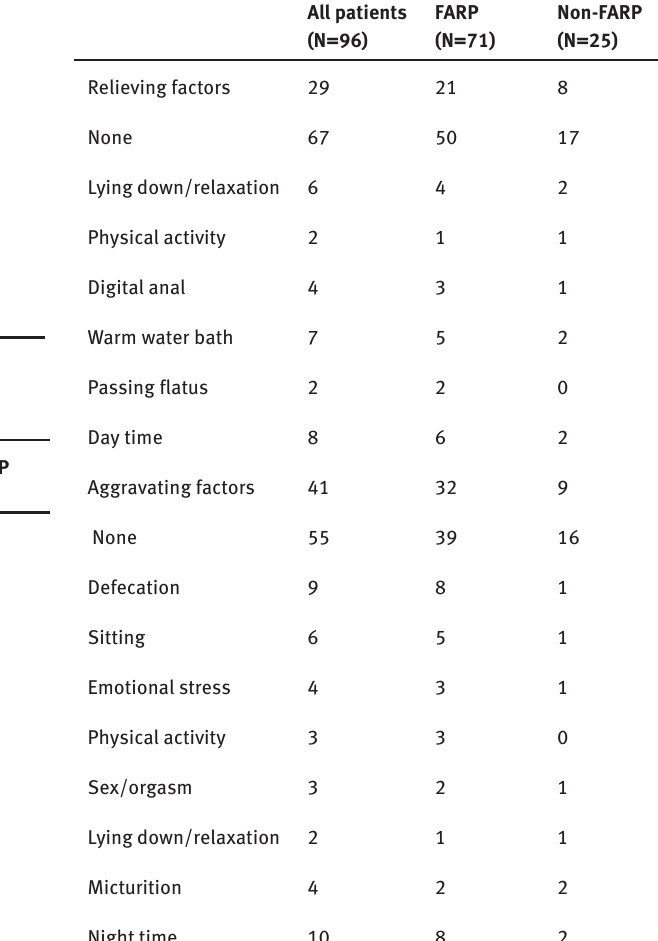
Table 4: The common pain relieving and aggravating